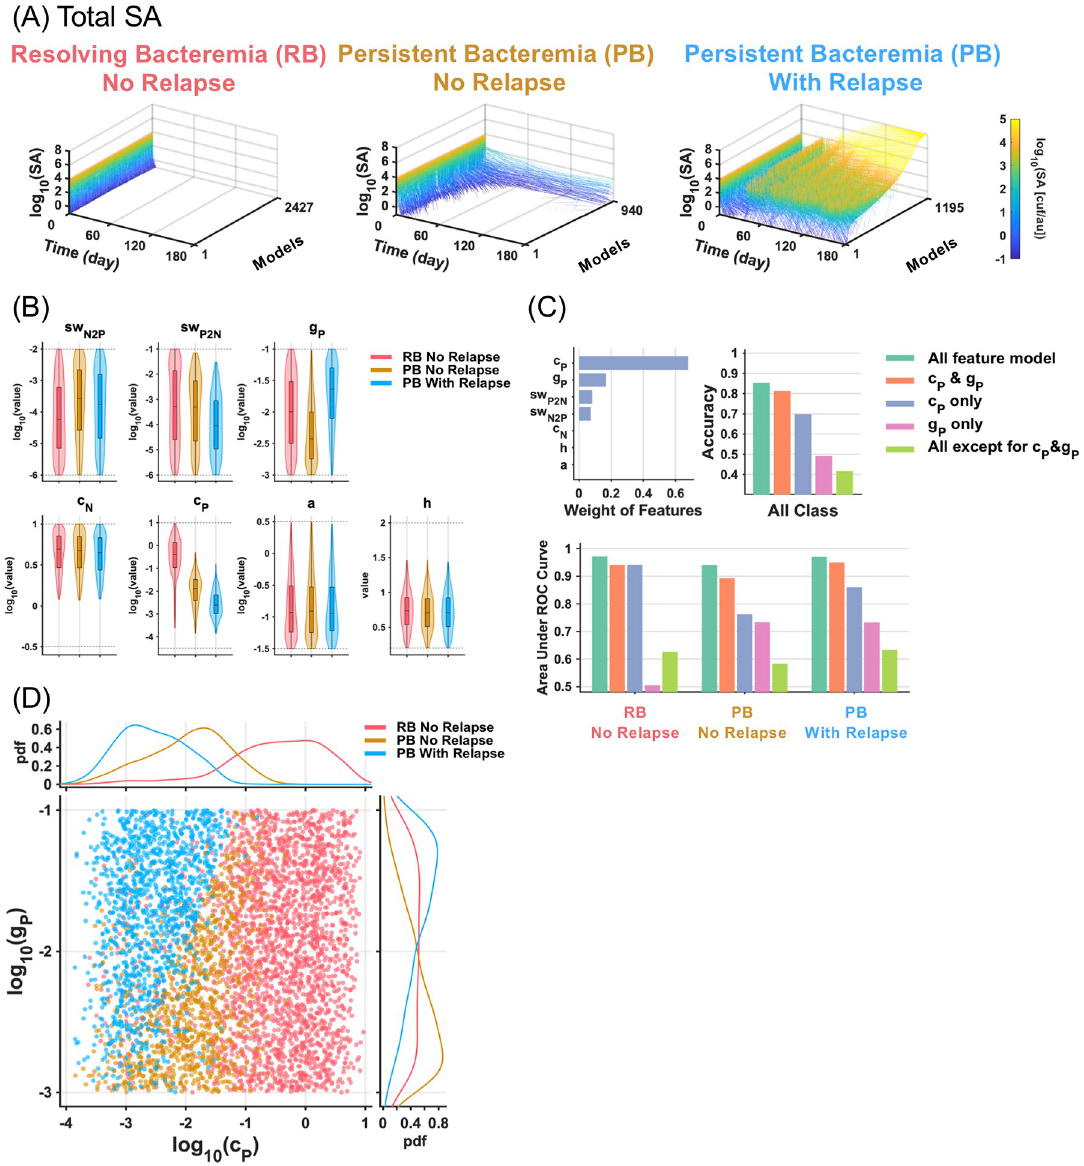
Fig 6. Key determinants to distinguish resolving, persistent and relapsing bacteremia. (A) Line plots of the number of total SA over time (0–180 days) for resolving bacteremia (RB) without relapse, persistent bacteremia (PB) without and with relapse bacteremia. (B) Violin plots and box plots of the parameter distributions. Dotted lines indicate the range of randomized parameter values. (C) Weights calculated by QPFS methods are shown. The ranked features by QPFS, c P and g P were used to build a multinomial logistic regression model. For the comparison, all parameter and all parameter except for c and g were applied to the classification model. The overall P P accuracy and area under ROC curve for each class are graphed. In the classification, an equal number of datasets in each class were used by reducing the number of data in major classes, RB without relapse and PB with relapse, to the same number of minor class, 940 of PB without relapse. (D) Two-dimensional scatter plot for c P and g P with probability density of each